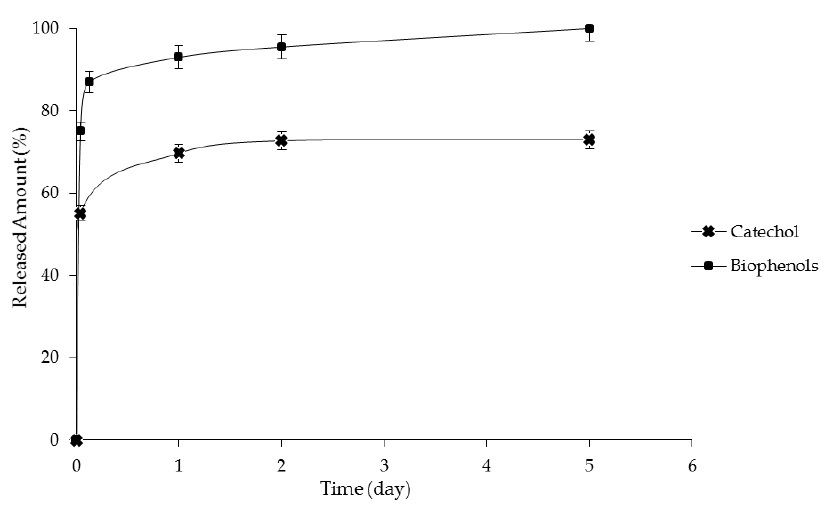
Figure 5. Catechol and biophenols release as a function of time.